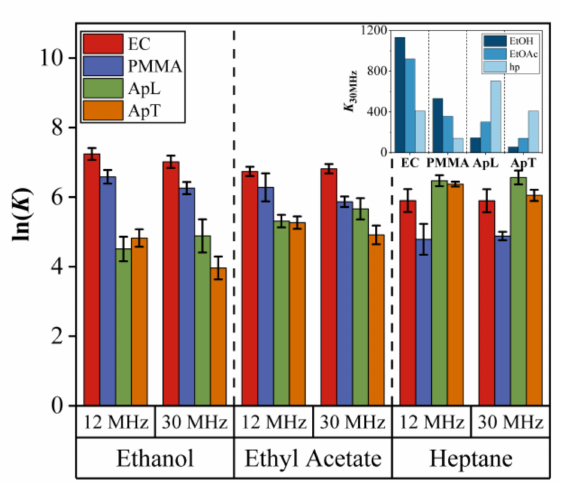
Figure 8. Comparison of the partition coe ffi cient ln ( K ) for 12QCM-SA and 30QCM-SA. Maximum deviation of 10% (error